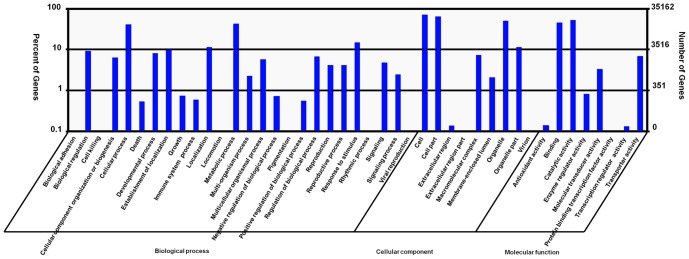
GO categories of biological process, cellular component and molecular function for the foliar transcriptome of C. amaranticolor.The right y-axis shows the number of genes in a category, while the left y-axis indicates the percentage of a specific category of genes in that main category.